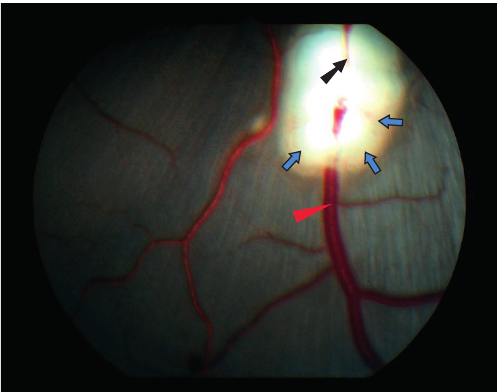
Figure 1: Dilation of vein due to downstream occlusion. The dilated section of the vein is marked with red triangle. The laser patch is marked with blue arrow. The site of occlusion is marked with black